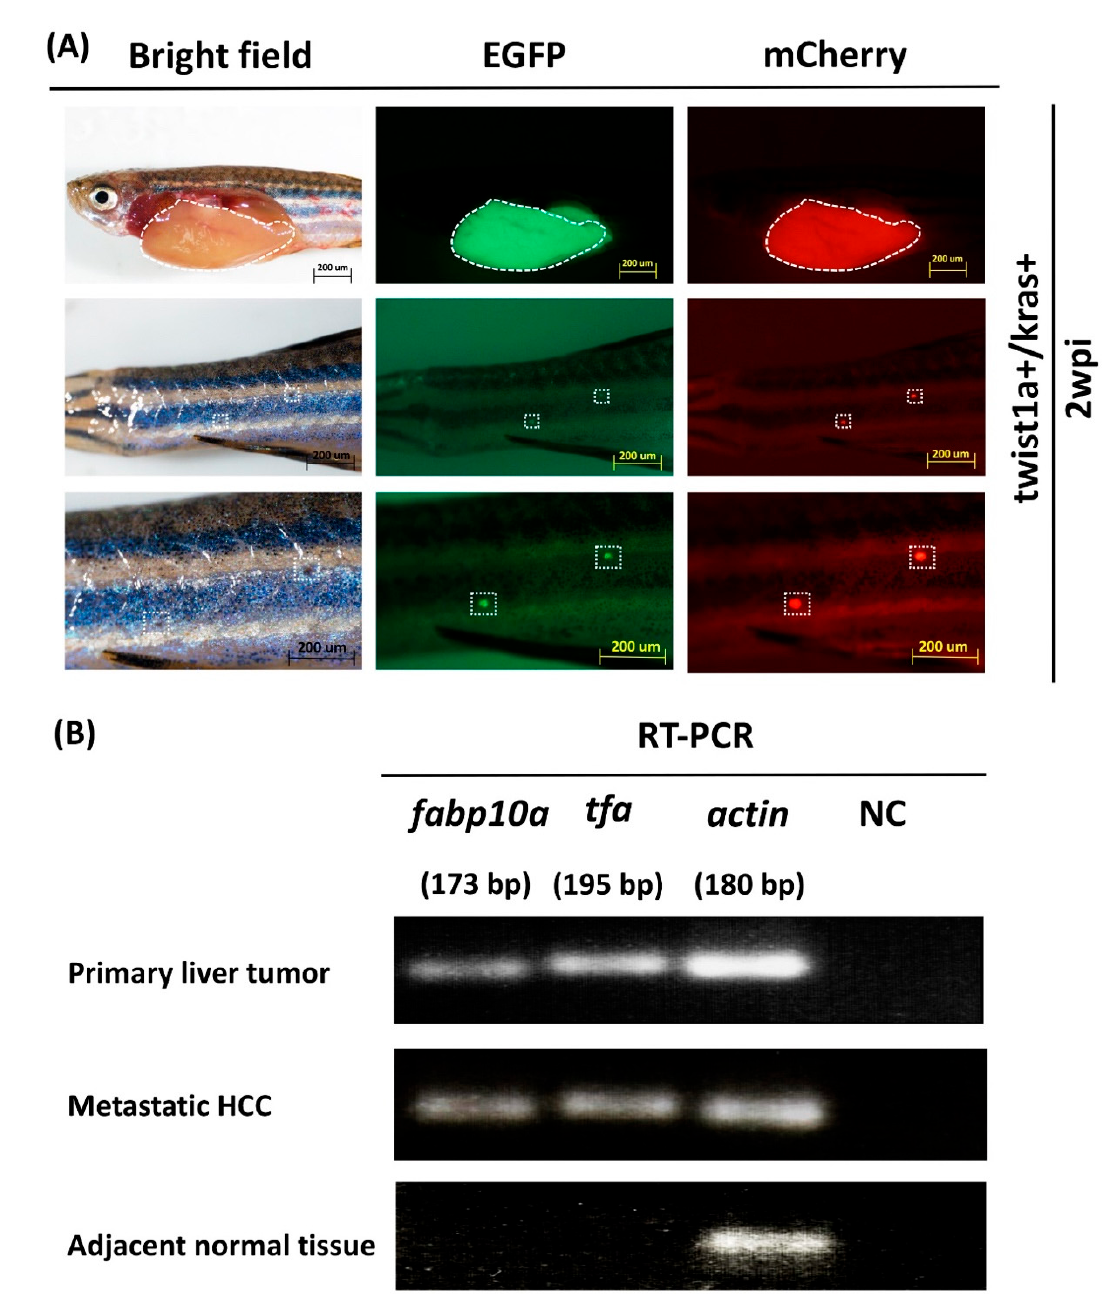
Figure 2. Liver markers in primary and metastatic liver tumor tissues from twist1a+/kras+ double transgenic zebrafish. ( A ) Immunofluorescence was used to visualize mCherry or EGFP-labeled metastatic liver tumors in twist1a +/ kras + zebrafish (white dotted line: primary and metastatic liver tumors). ( B ) Semi-quantitative RT-PCR data showing expression levels of fabp10a and tfa in primary liver tumors, metastatic HCC tissues, and adjacent normal muscle tissues. Actin and non-template samples were respectively used as positive and negative controls. Scale bar: 200 μ m.